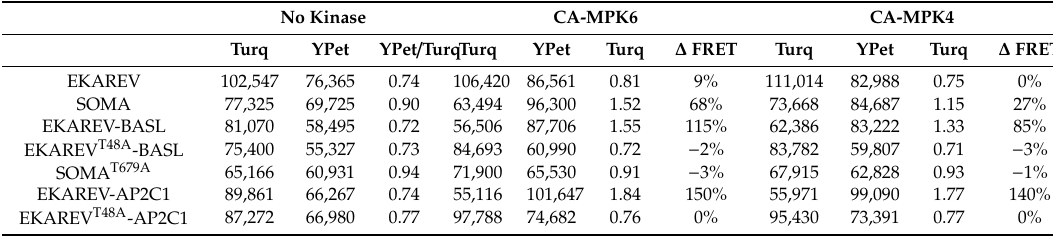
Table 1. In vitro FRET of EKAREV and SOMA